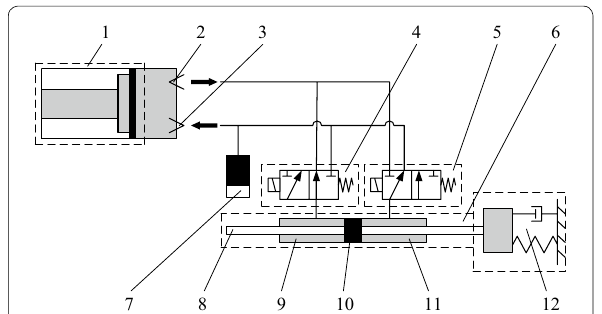
Figure 19 New type of electro-hydraulic vibration equipment driven by magnetostrictive driven pump. 1. Magnetostrictive drive pump; 2. First check valve; 3. Second check valve; 4. First directional control valve; 5. Second directional control valve; 6. Double rod hydraulic cylinder; 7. Accumulator; 8. Piston rod; 9. Left oil chamber; 10. Piston; 11. Right oil chamber; 12. Excited